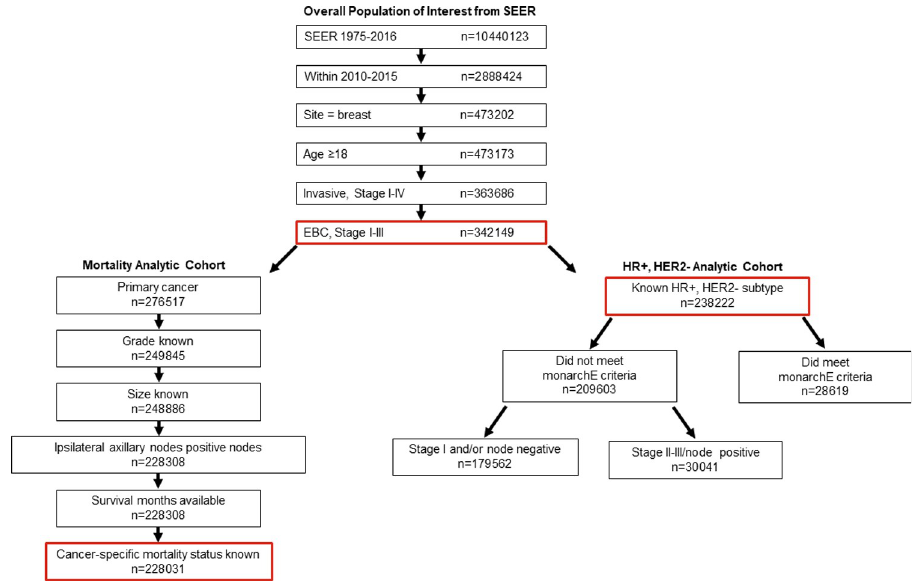
Fig 1. Patient attrition from the overall SEER population based on defined inclusion and exclusion criteria. Abbreviations: EBC, early breast cancer; HER, human epidermal growth factor receptor; HR, hormone receptor; SEER, Surveillance, Epidemiology, and End